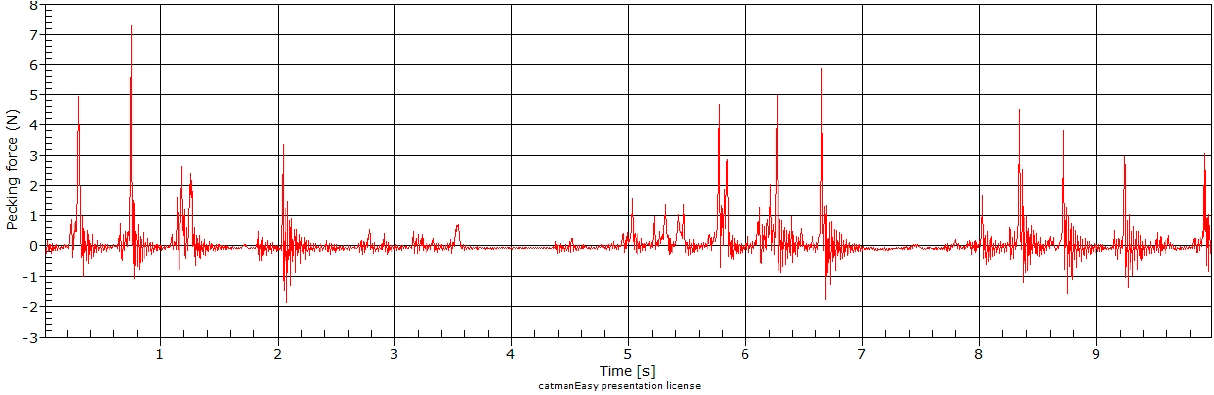
Figure 4. Pecking force at ten-second time length.